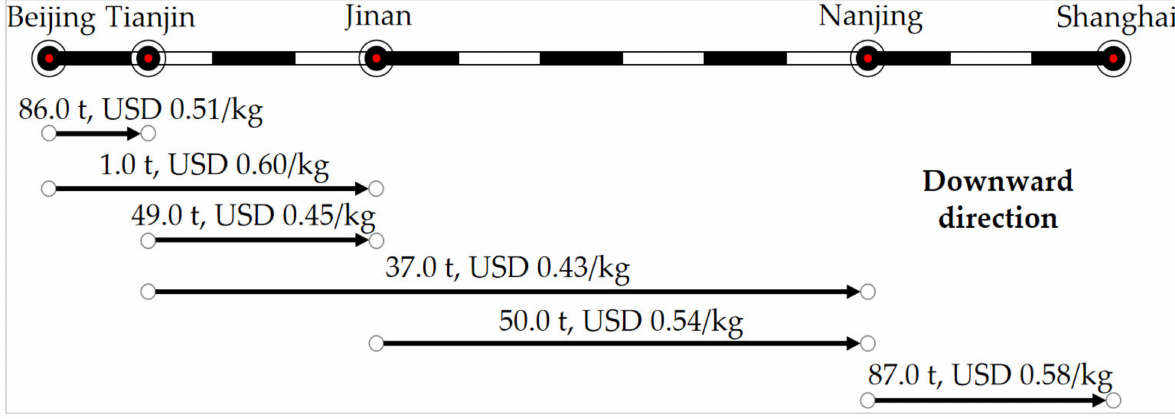
Figure 2. The solution results of the downward direction.